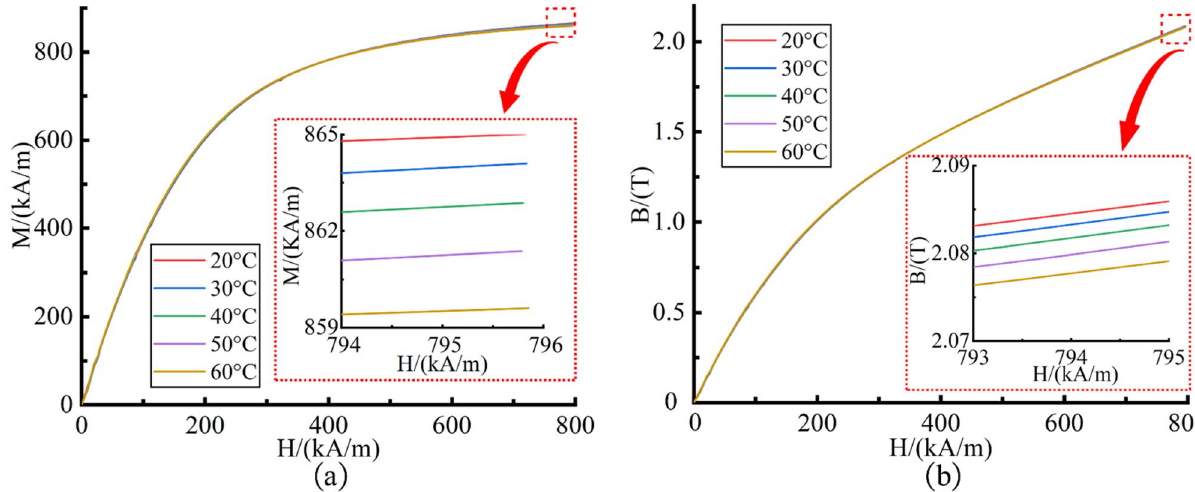
Figure 4. The magnetization properties curves of CIP. ( a ) The magnetization intensity curves at different temperatures; ( b ) The B-H curves at different